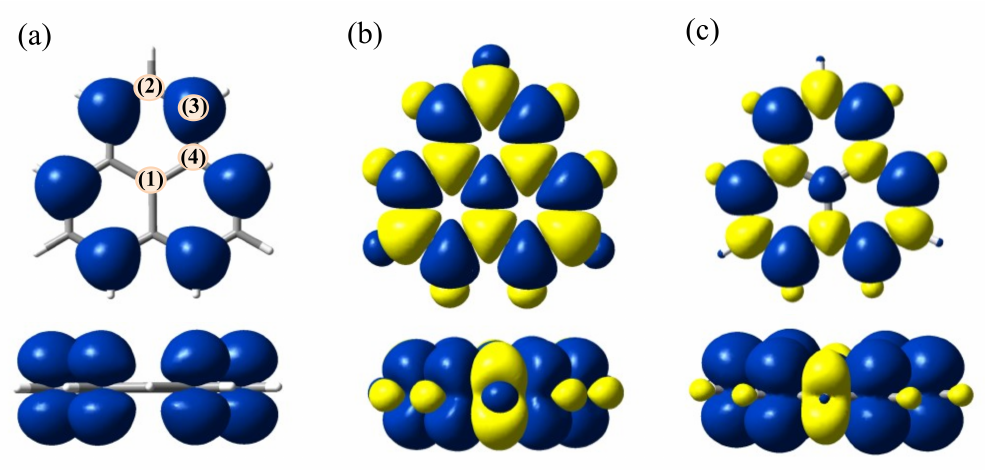
Figure 3. Spin density maps (drawn at 0.001 e/Å 3 isosurfaces) from different single-determinant calculations: ( a ) ROHF ( α -only); ( b ) UHF ( α -in blue, β -in yellow); ( c ) UKS result, with B3LYP functional. Note that UHF shows a non-physical enhancement of spin polarization, with comparably large α vs. β